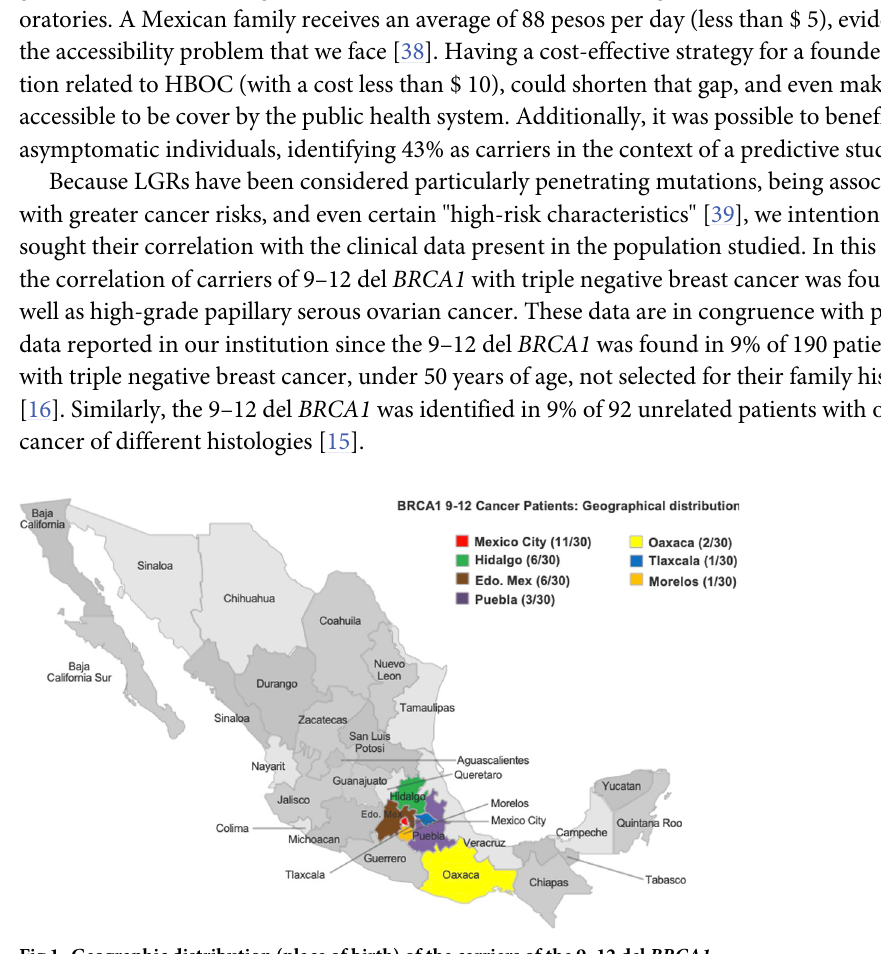
Fig 1. Geographic distribution (place of birth) of the carriers of the 9–12 del BRCA1